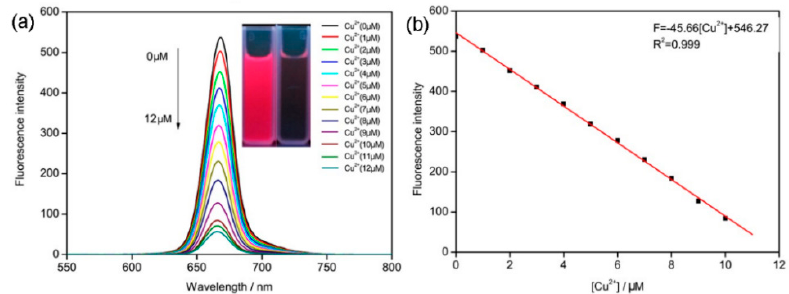
Figure 2. ( a ) Fluorescence spectra of [ ACP -Cu 2+ ] with emission wavelength 668 nm; ( b ) The relation between ACP fluorescence intensity and the concentration of Cu 2+ .